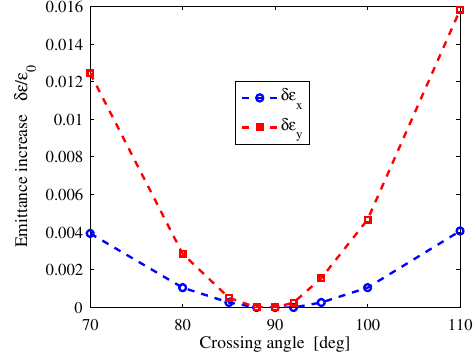
FIG. 12. Projected emittance increase versus the cross angle of the two